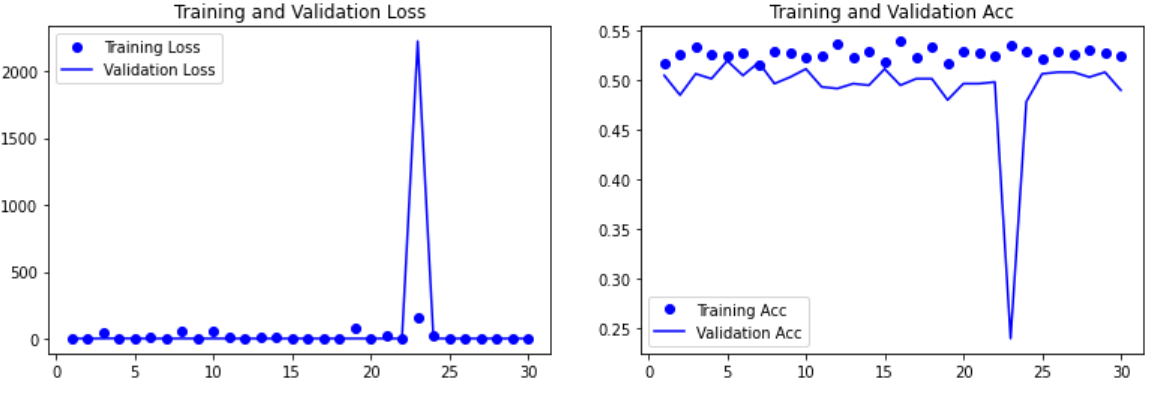
Figure 5. Training and validation loss using two participant data